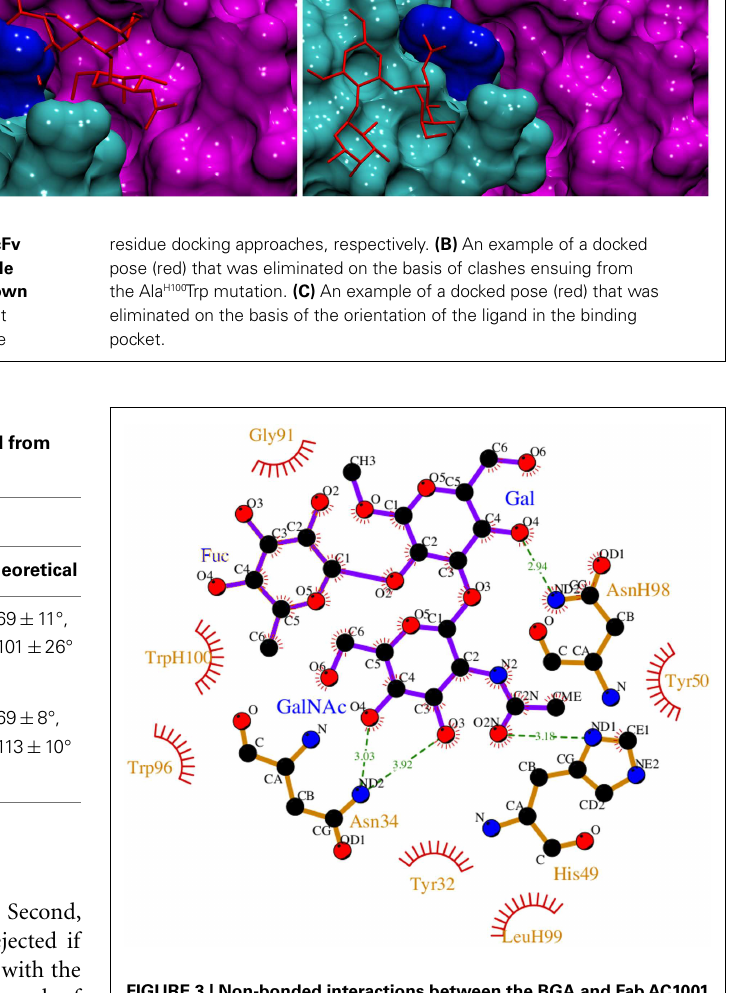
ψ 2 ) linkages were monitored throughout both the simulations (BGA–scFv complex and BGA trisaccharide in solution) and the average values were found to be in agreement with the values observed for the same trisaccharide in the complex with Dolichos biflorus lectin as well as the conformations of the trisaccharide in solution (35) ( Table 1 ). The stacking interactions between the GalNAc and Trp H96 interactions were characterized by the angle ( θ ) between the normals to the ring planes, and the distance ( R ) between their centroids (36). For an ideal stacking conformation, θ should be around 180° or 0°, and for CH/ π , it should be around 90°. The average θ value was close to the latter at 108° (with a standard deviation of 9°) at a distance of 6.5